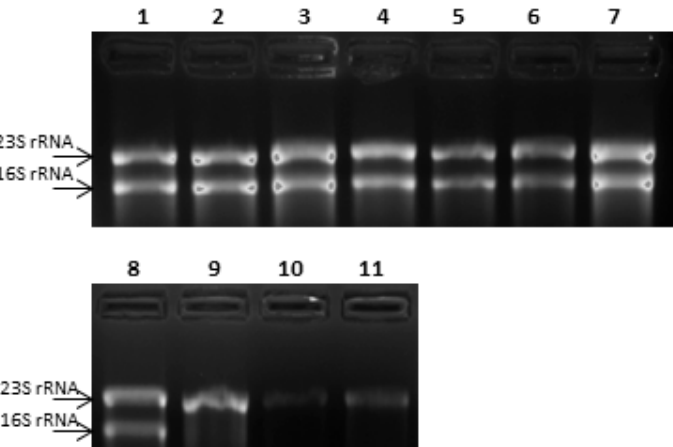
Figure 3. 16S rRNA degradation after thermal stress conditions. Denaturing gel electrophoresis of total RNA extracted from L. paracasei 4366. 1, control; 2, nutritional stress; 3, acidic stress; 4, osmotic stress; 5, oxidative stress; 6, ampicillin; 7, kanamycin; 8, control; 9, thermal stress (30 min); 10, thermal stress relief; 11, thermal stress (2 h). Black arrows indicate the 23S rRNA and16S rRNA. Table 5. C t range and gene-stability score (M) for the selected genes in L. paracasei ATCC 334. Strain Target Min ( C t) Max ( C t) Range